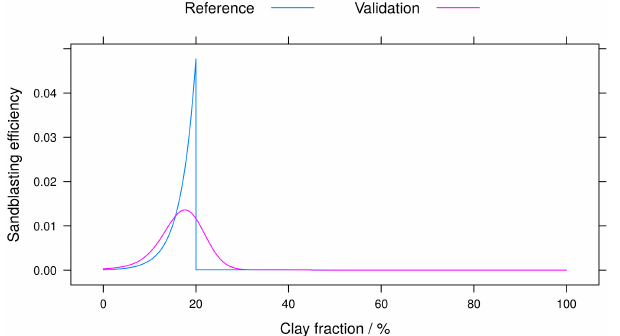
Figure 4. Global map of the sandblasting efficiency obtained by ap- plying the filtered efficiency function shown in Fig. 3 to the GSDE clay fraction data. Regions where the land cover mask precludes emissions throughout the period of available land cover data (2001 to 2012) are